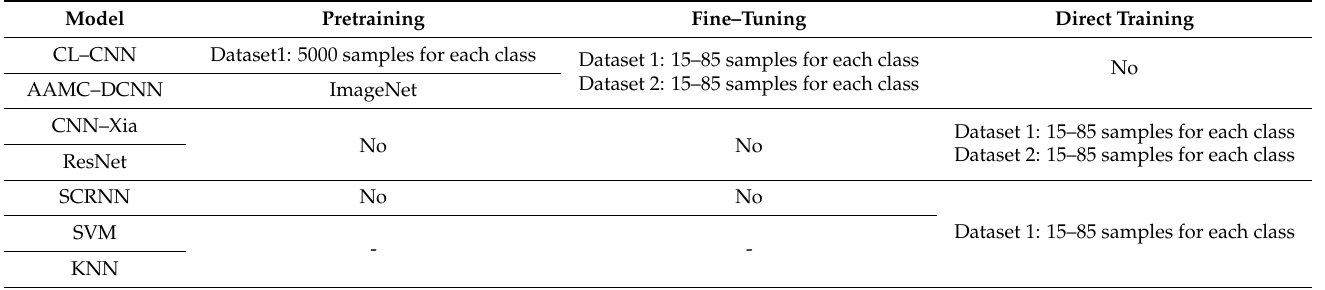
Table 4. The implementation details of the deep models and traditional methods.